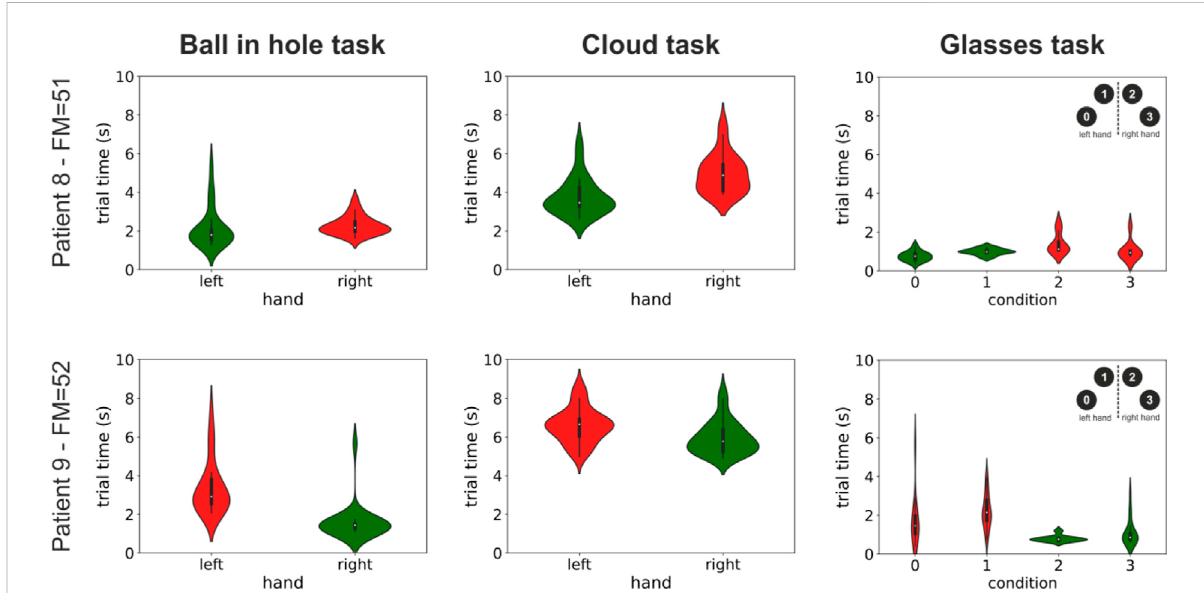
FIGURE 3 Distribution ofcompletiontimesfor threetasksandtwopatients.The violinplotsshowthedistributionsofthetimestakentocompletethreeof the tasks presently implemented in our system (three columns) for two patients. Patient 12 was a 78-year old male with a right-side impairment, and patient13wasa63-yearoldfemalewithaleft-sideimpairment.Distributionsarecolorcodeddifferentlyforthehealthyandimpairedlimb(greenand red respectively). The label on the vertical axis shows the patients ’ id and their Fugl-Meyer score. See Supplementary Figure S3 in the supplementary information for similar plots for all other